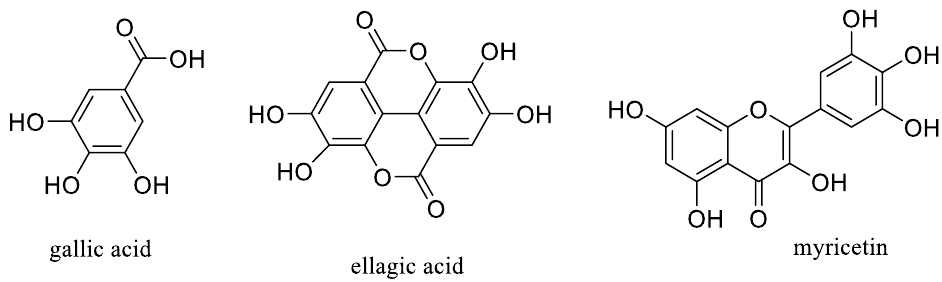
Figure 3. Structures of gallic acid, ellagic acid, and myricetin identified from Aronia berries. The combined or individual aqueous extracts of the frozen fresh fruits of Aronia melanocarpa and Sambucus nigra L. (elderberries) were tested against four human respiratory tract viruses, influenza A virus (A/H1N1), β -coronavirus-1 (HCoV-OC43), human herpesvirus type 1 (HHV-1), and human adenovirus type 5 (HAdV-5), of which A/H1N1 and HCoV-OC43 belong to the same β -coronavirus group as the virus found to be the cause of the current pandemic, COVID-19. A combined extract of these two types of berries showed antiviral activity against A/H1N1 and HCoV-OC43, but their activity toward HHV-1 and HAdV-5 was much less evident. The individual extracts of Aronia berries or elderberries exhibited inhibitory activity against A/H1N1, but neither of these extracts possessed any activity against HCoV-OC43 [53]. These results indicate that the mechanisms of action of the extracts of Aronia berries or elderberries against A/H1N1 and HCoV-OC43 could be different, and that the components of these berries may synergize with each other in their inhibitory effects against